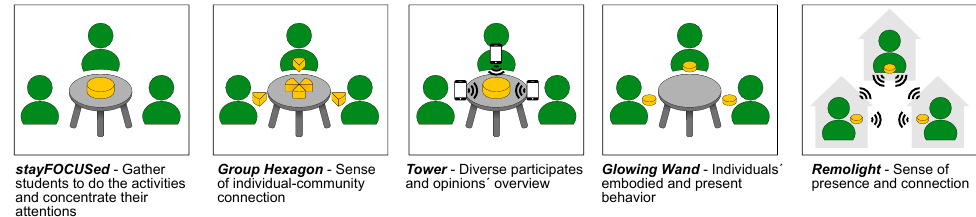
Figure 1. Communicative mechanisms for developing tangibles in our